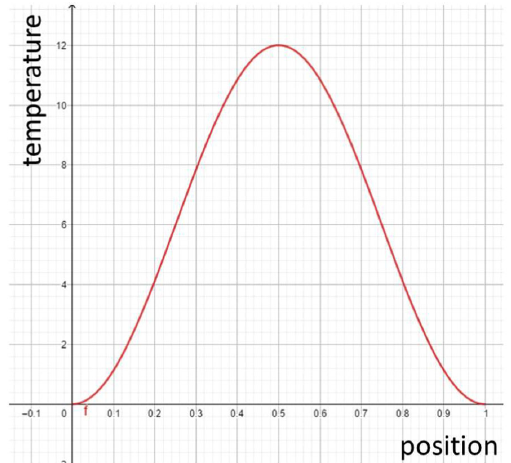
FIG. 13. IC given in the previous problem (which is not discussed in this paper). It has the shape of a shifted sine